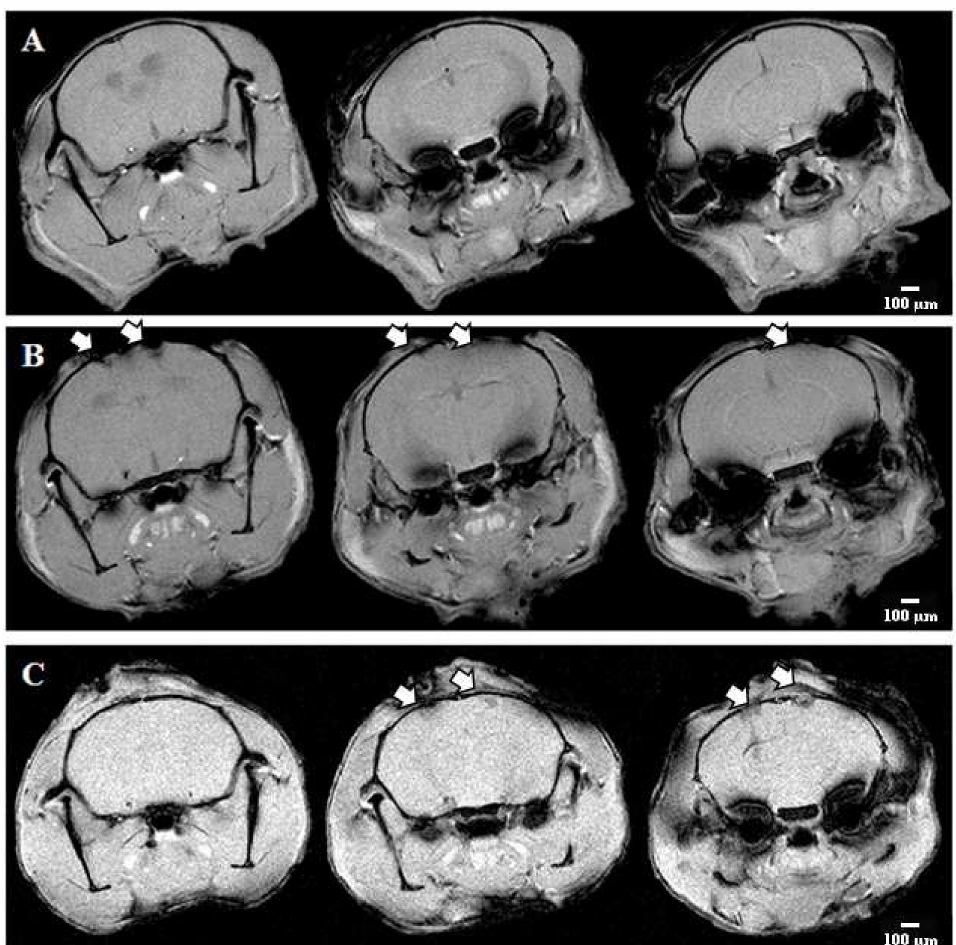
Figure 7. Representative MRI scans of the brain of mice in the modeling of acute ischemic brain injury. ( A )—Intact, ( B )—Ischemia, and ( C )—Ischemia + RIPK inhibitor Necrostatin-1. White arrows indicate the active areas of ischemic lesion’s